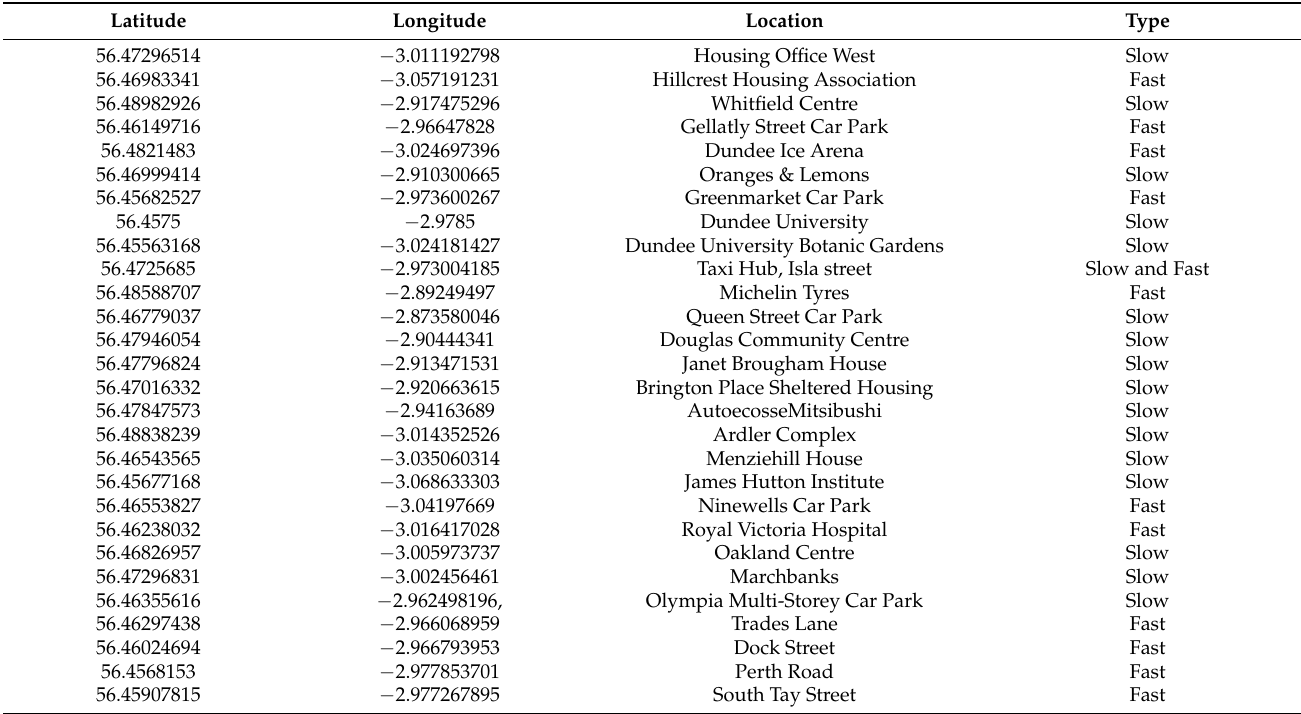
Table 5. Commercial public charging hotspots for Dundee city council.